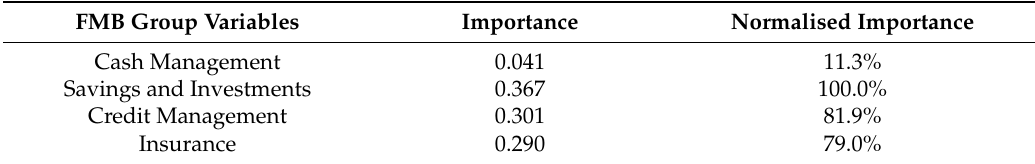
Table 7. Independent variable importance for Model C (calculated by the